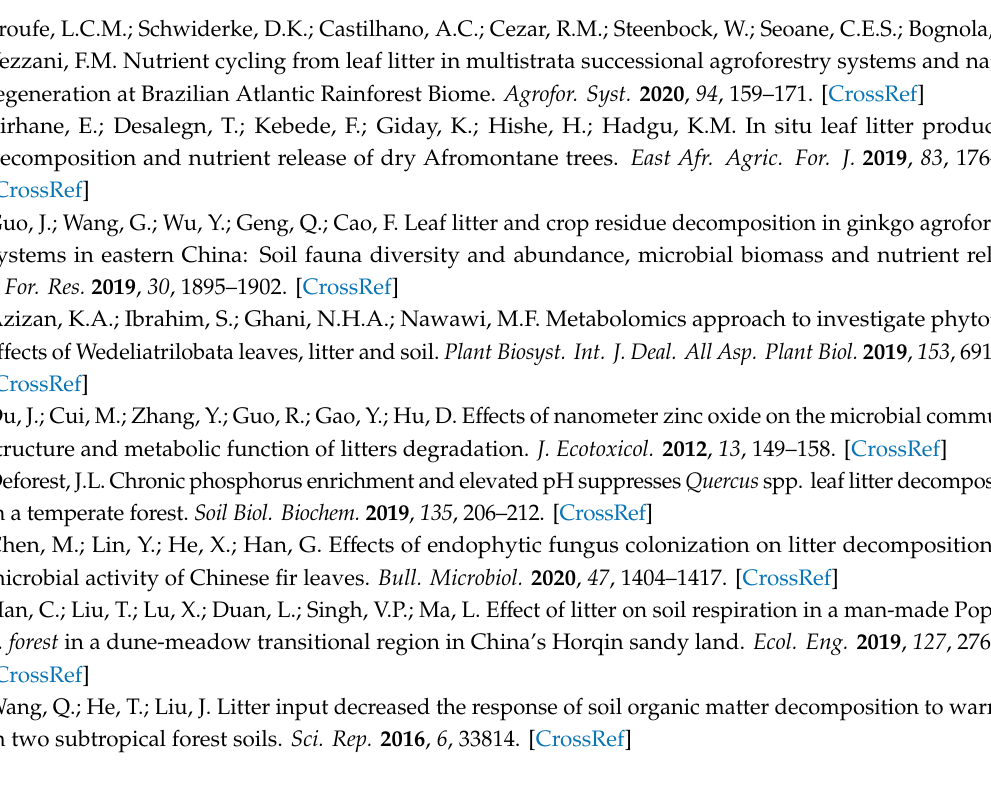
Figure A2. Principal component analysis of fungal litter communities in two types of litter from plantation forest (A) and original forest (B).